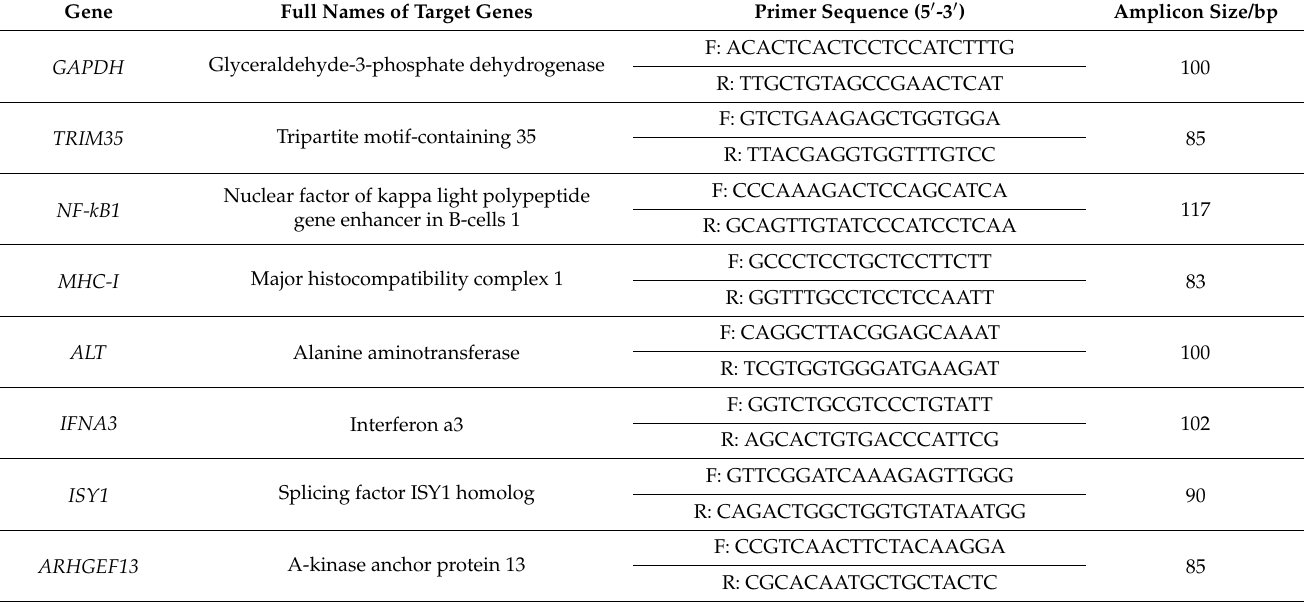
Table 2. Relevant primer